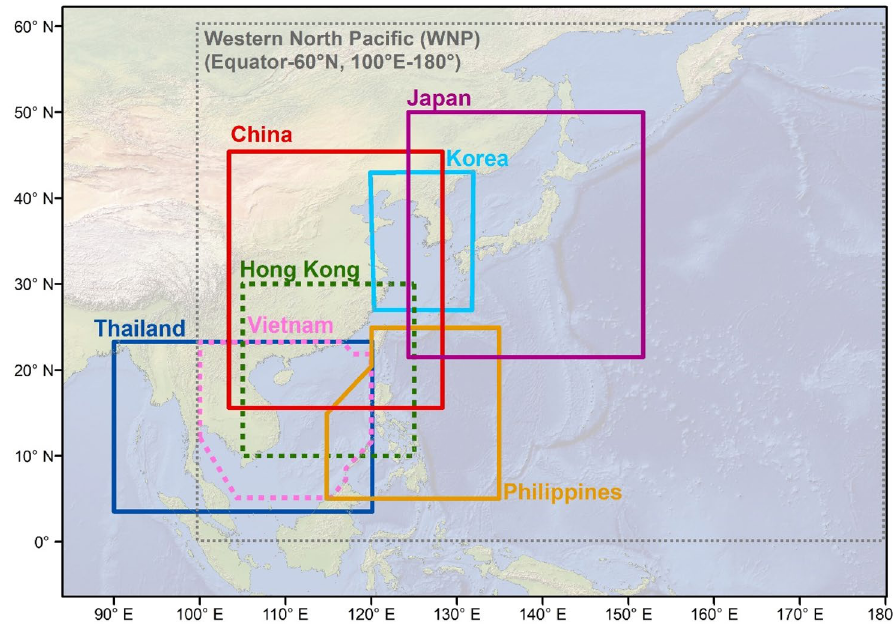
Figure 1. Western North Pacific (WNP) and seven sub-regional locations considered in this analysis. Figure created using a baseamp from Natural Earth (www. natur alear thdata. com).